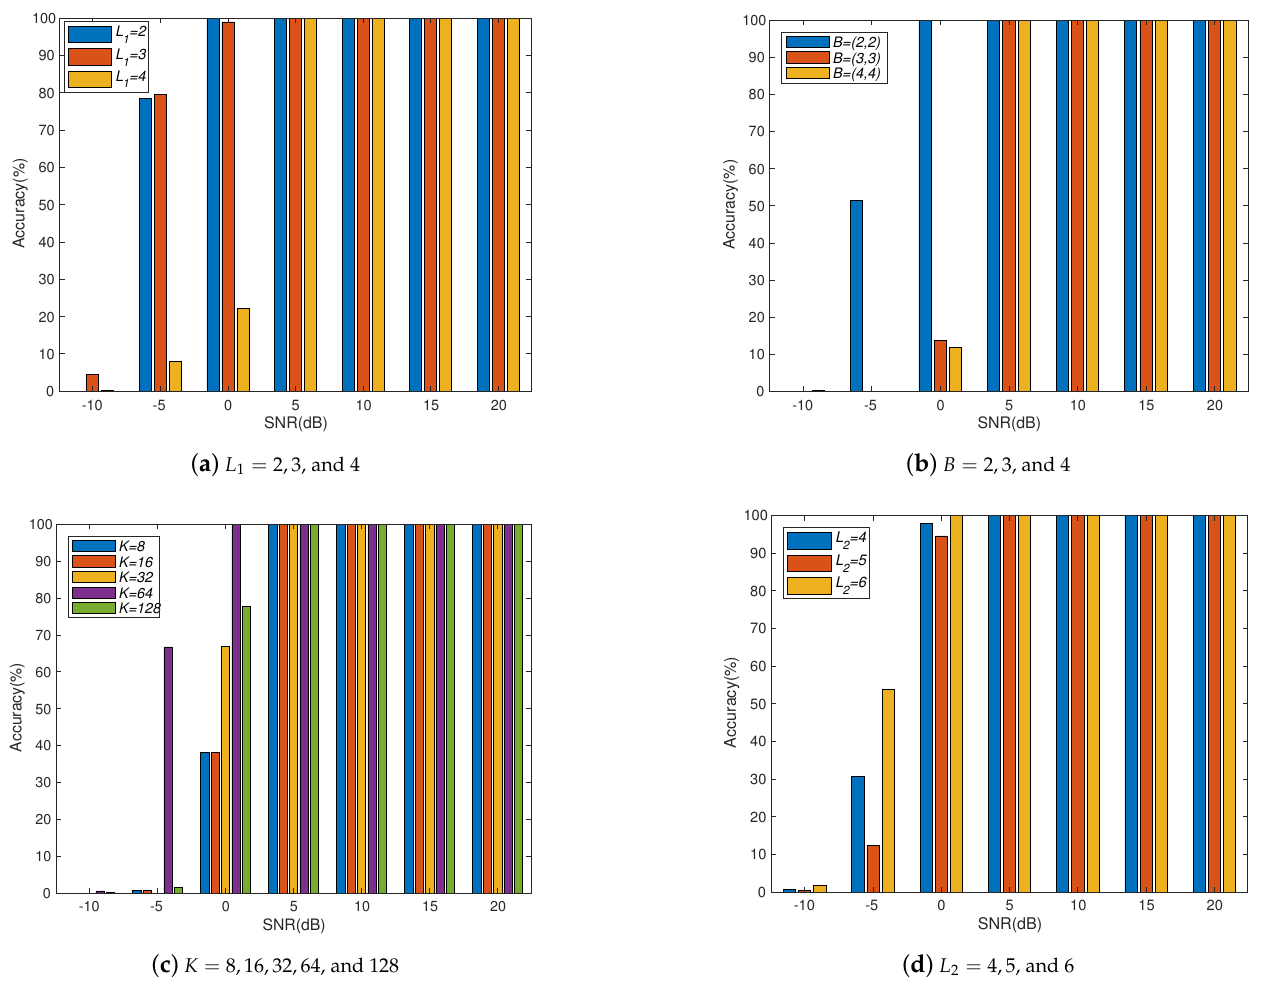
Figure 5. The influence of four CAE parameters on performance: ( a ) accuracy of different numbers of encoding layers L 1 versus SNR, ( b ) accuracy of different kernel sizes B × B versus SNR, ( c ) accuracy of different numbers of kernel K versus SNR, ( d ) accuracy of different numbers of decoding layers L 2 versus